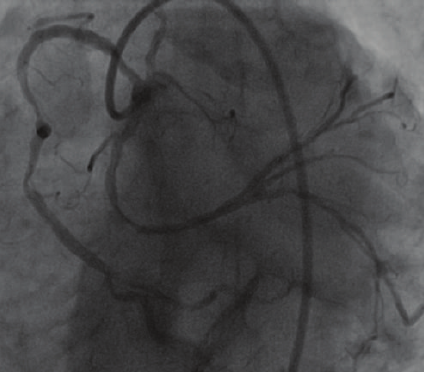
Figure 4: Severe coronary artery stenosis detected on cardiac